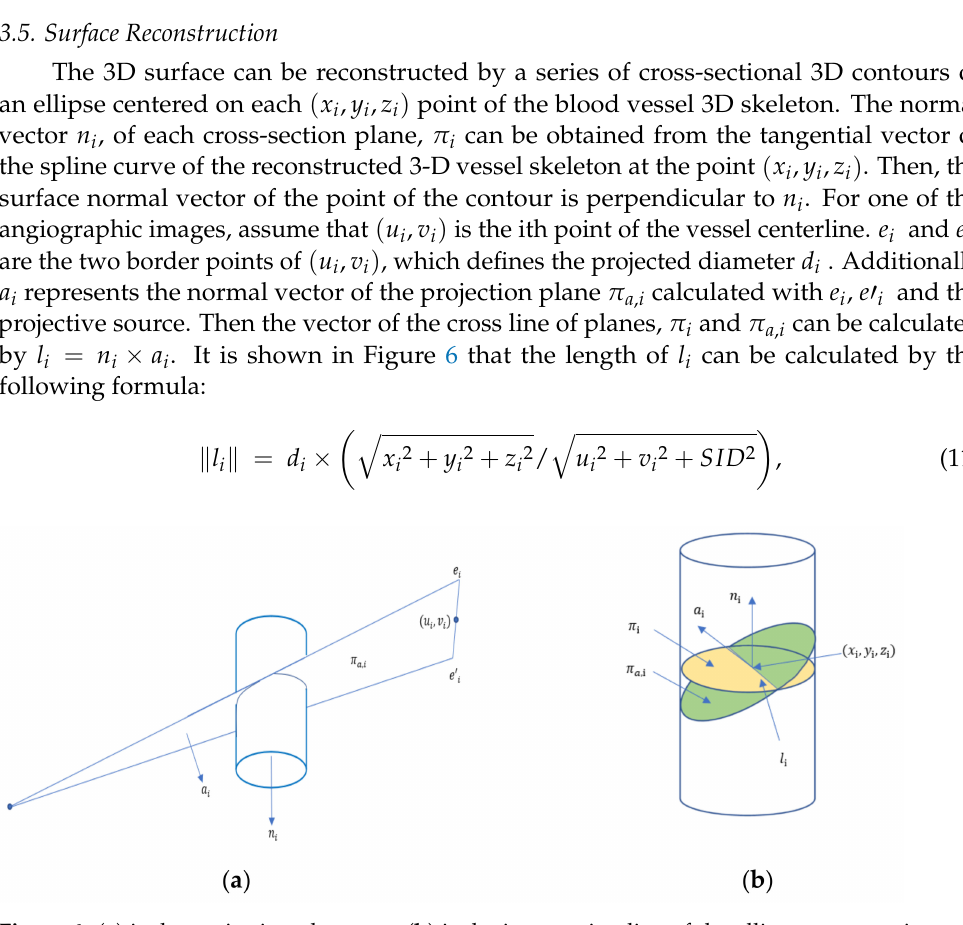
Figure 6. ( a ) is the projective plane π a , i ; ( b ) is the intersection line of the ellipse cross-section and projective